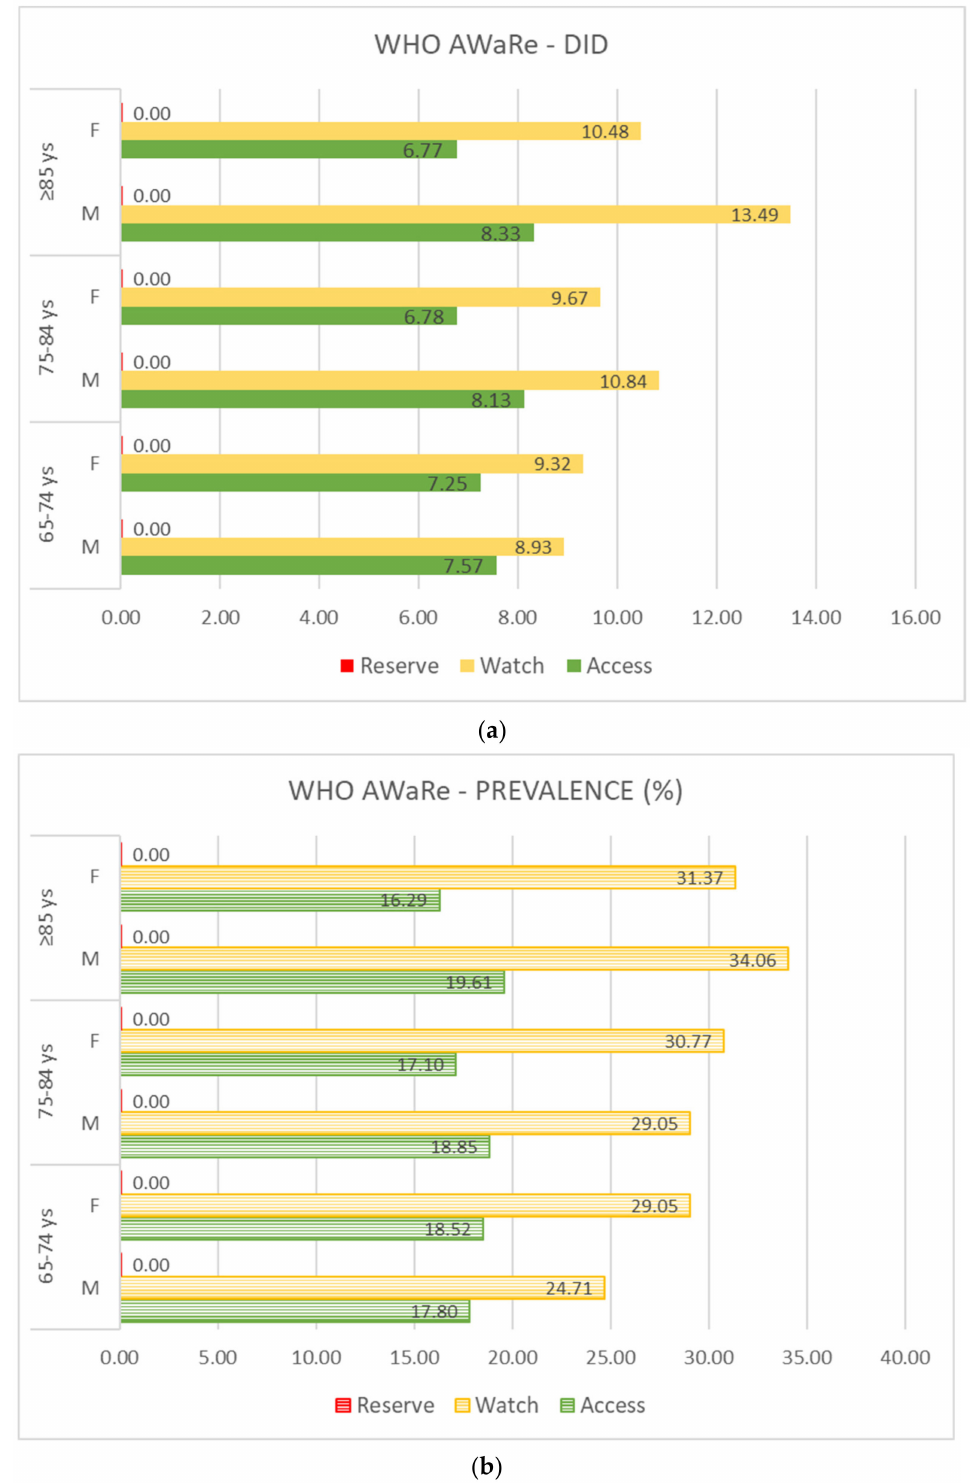
Figure 1. Antibiotic consumption (expressed in DID, panel ( a ) and prevalence rates (%), panel ( b ) according to the WHO-AWaRe (Access, Watch, Reserve) classification system, stratified by sex and age